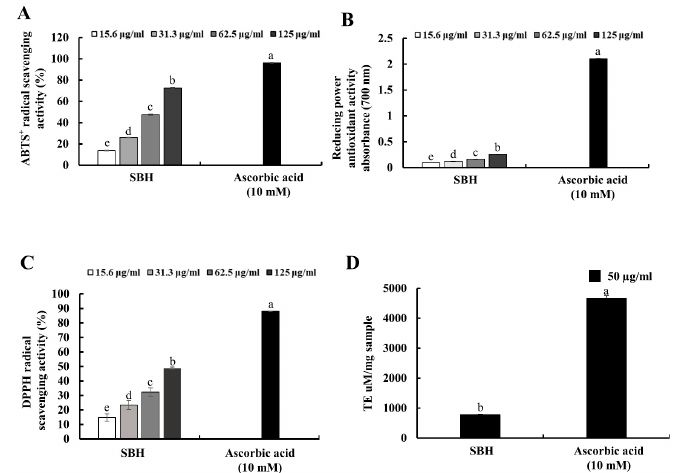
Figure 2. Antioxidant activities of SBH. ( A ) ABTS + radical scavenging; ( B ) reducing power; ( C ) DPPH radical scavenging; and ( D ) oxygen radical absorbance capacity of SBH. Experiments were carried out in triplicate and results were represented as means ± standard deviation (SD) ( n = 3). Means denoted by different letters are significantly different at p < 0.05. 3.4. SBH Abate Oxidative Stress in H 2 O 2 Stimulated Vero Cells